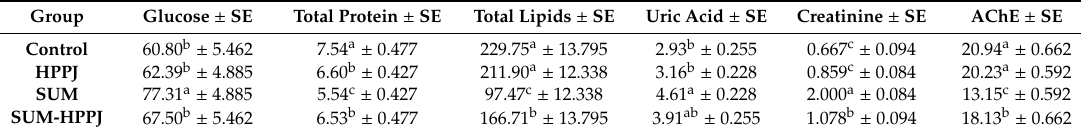
Table 3. Mean ± SE values of glucose (mg / dL), total protein (g / dL), total lipids (mg / dL), uric acid (mg / dL), and creatinine (mg / dL) contents and acetylcholine esterase (AChE; nM ATChI / min) activity of white albino rats who were orally given corn oil (Control), sumithion (SUM; 85 mg / kg, 1 / 20 LD 50 ), HPPJ (a mixture of citrus bee honey, propolis, palm pollen grains, and royal jelly), and SUM-HPPJ for 28 consecutive